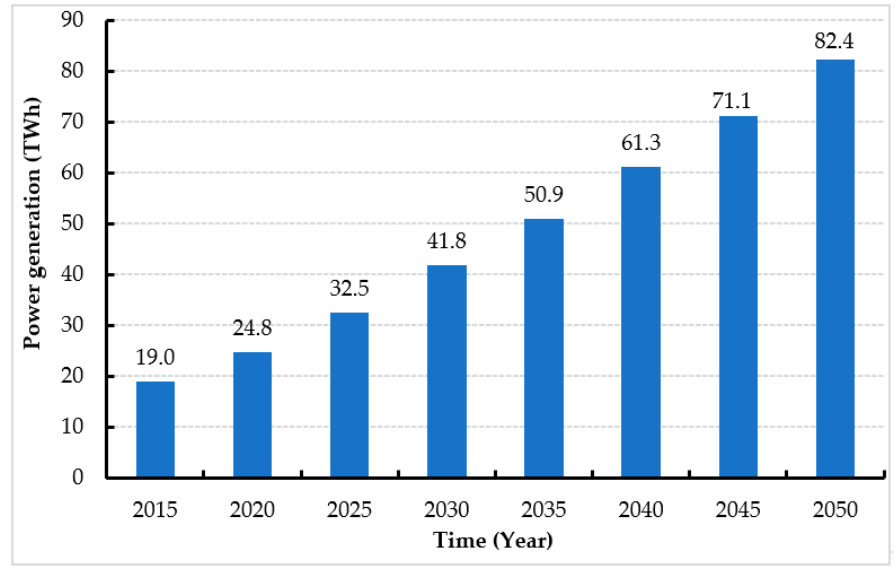
Figure 7. Jordan’s electricity requirements between 2015 and 2050.